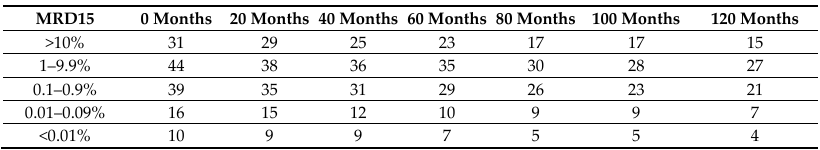
RFS-relapse free survival, MRD15-minimal residual disease on day 15. Censored events are marked with a tick through the line. Figure 2. Relapse free survival of patients with respect to MRD15, p = 0.269. Figure 2. Relapse free survival of patients with respect to MRD15, p = In our study, the 0.1% MRD cut-off was the most discriminatory for all patients at all time points evaluated. On day 15 patients with MRD > 0.1% have a lower OS and RFS rate compared to patients with MRD < 0.1% (93.1% vs. 100%, p = 0.08; 78.2% vs. 96.2%, p = 0.027, respectively). At EOI and EOC, the difference in OS and RFS rates between children with MRD below 0.1% and those with MRD < 0.1% was even clearer and reached statistical significance (Table 6, Figure 3A–C).